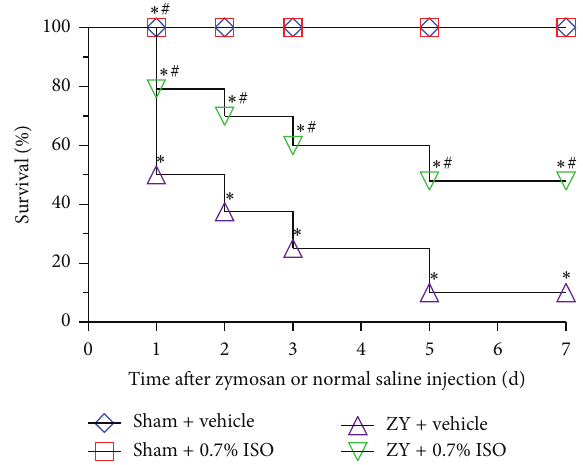
Figure 2: Effect of 0.7% ISO treatment on mortality of ZY- challenged mice. Mice were treated with RA (vehicle) or ISO inhalation for 1hr at 1 and 6 hrs after NS (sham) or ZY injection. The survival percentage was calculated each day for 7 days following initial treatment ( 𝑛 = 20 per group). ∗ 𝑃 < 0.05 versus sham + vehicle; # 𝑃 < 0.05 versus ZY +